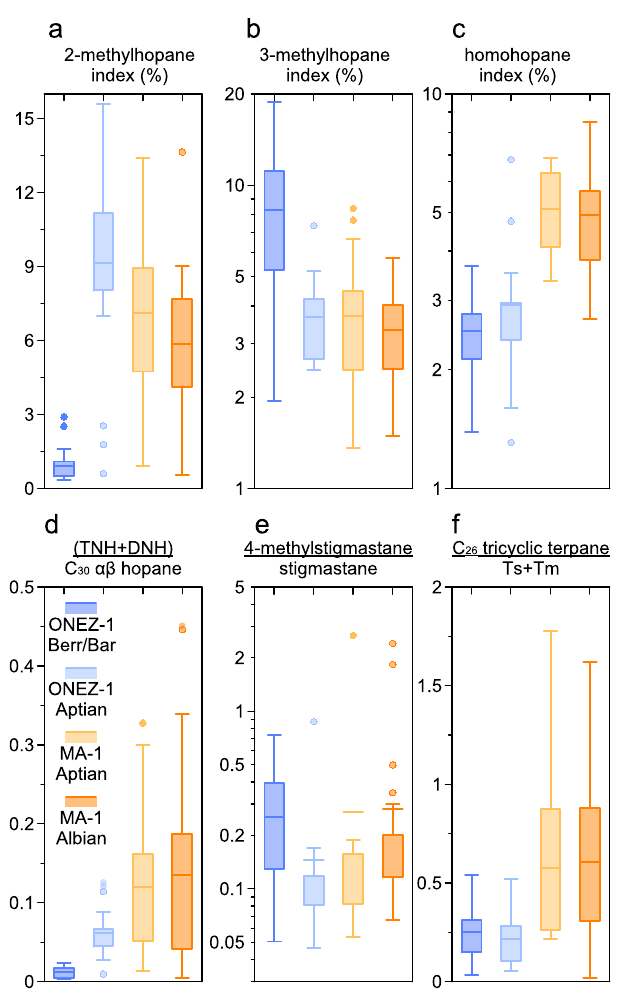
Fig. 3 Box-whisker plots for six sterane, hopane and tricyclic terpane biomarker proxies. a – c are 2-methylhopane index, 3-methylhopane index and homohopane index in percentage (%), respectively, as de fi ned in the Supplementary Table 1. d The sum of trinorhopane (TNH) and 28,30- dinorhopane (DNH) over C 30 αβ hopane. e The relative abundance of 4-methylstigmastane and stigmastane. f The ratio of C 26 tricyclic terpane over 18 α (H)-22,29,30-trinorneohopane (Ts) and 17 β (H)-22,29,30- trinorhopane (Tm). Sample groups and plots were de fi ned the same as in (Fig. 2). The interpretation of each proxy is discussed in the main text and the supplementary fi